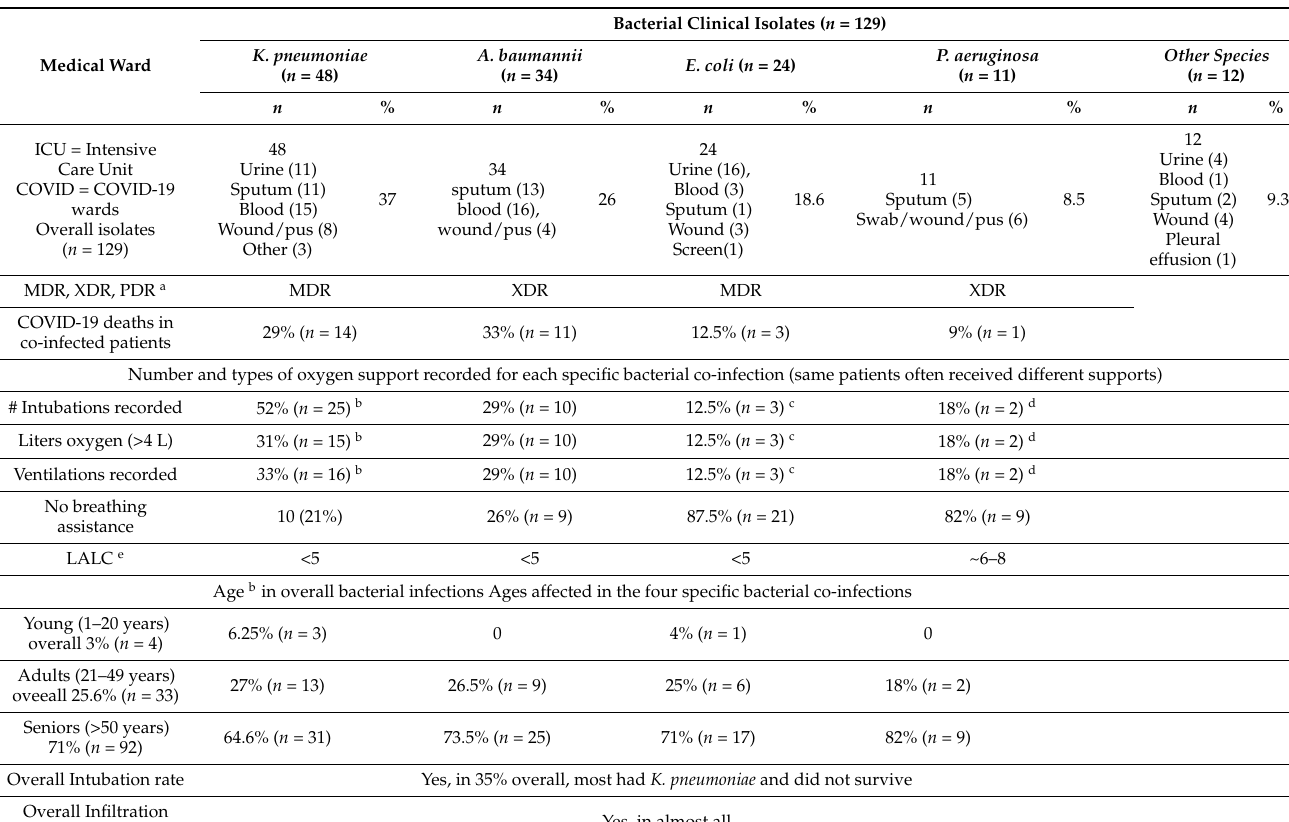
Table 1. COVID-19 clinical profiles, bacterial co-infection, and patient demographics and outcomes in Ha’il,